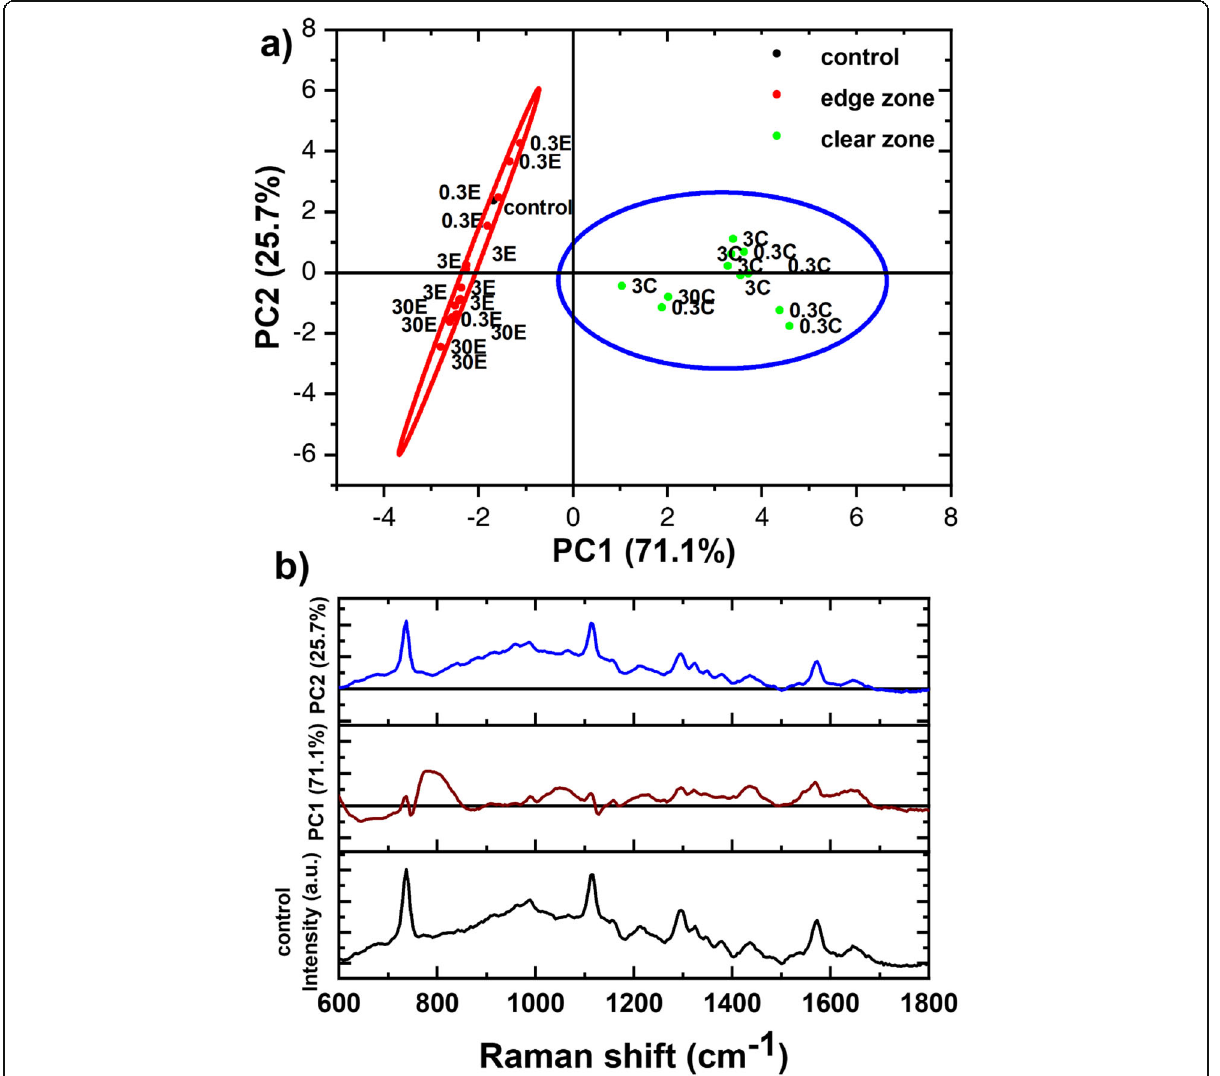
Fig. 4 PCA a score plot and b loading plot of TCMTB affected A. hydrophila . Raman data plotted for PC1 and PC2 with increasing concentrations (0.3%, 3% and 30%). Spectra were offset for